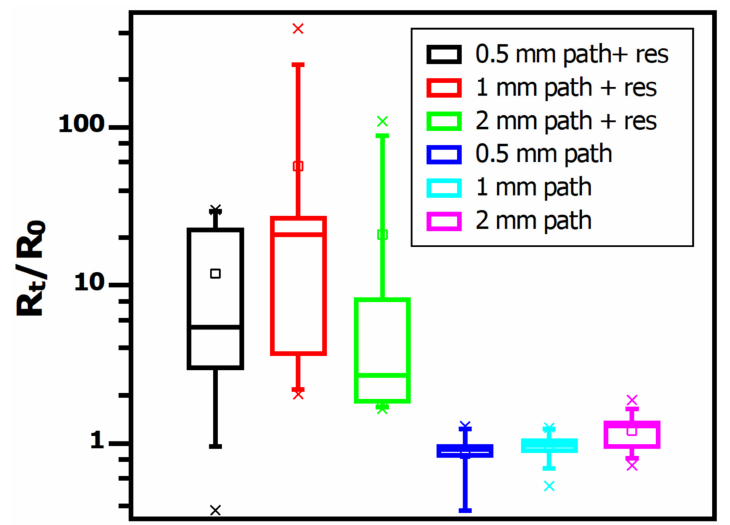
Figure 5. Change of resistance of 3D printed samples after accelerated aging test. R t represents resistances after test and R 0 means initial values. The designation “+ res” indicates paths with a 0 Ω